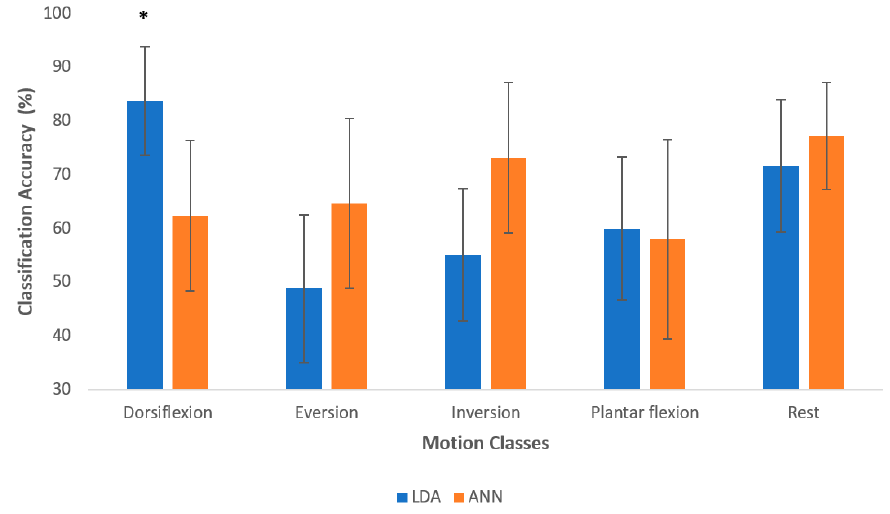
Figure 4. The average classification accuracy for all motion classes across all participants. The results are reported as mean ± standard deviation and asterisk denotes significant differences between motion class for each classifier. The asterisk denotes statistically significant difference.